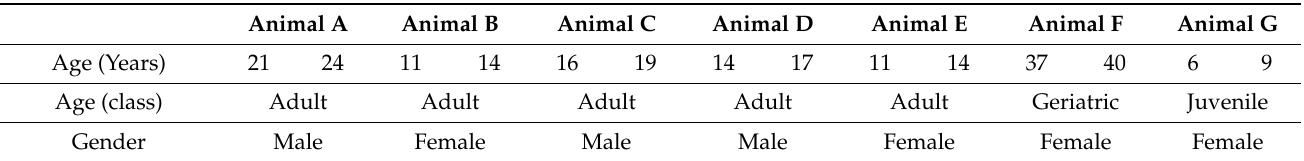
Table 1. Signalment of the seven dolphins included in the study. Regarding age, for each animal, the left and right columns represent the age at the first and last samples analyzed, respectively. Age classes were determined according to Venn-Watson and colleagues (2007)